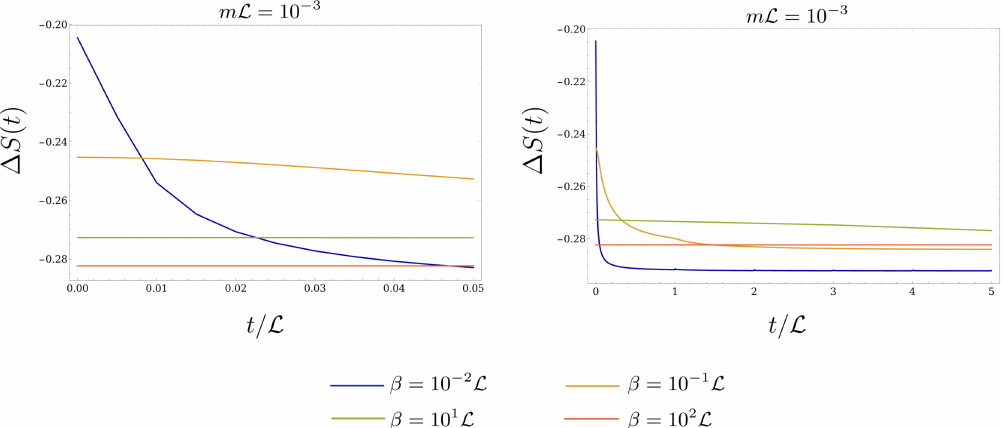
Figure 12 . Temperature effect on time evolution of ∆ S = S OEE − S EE . We take N = 1501 and